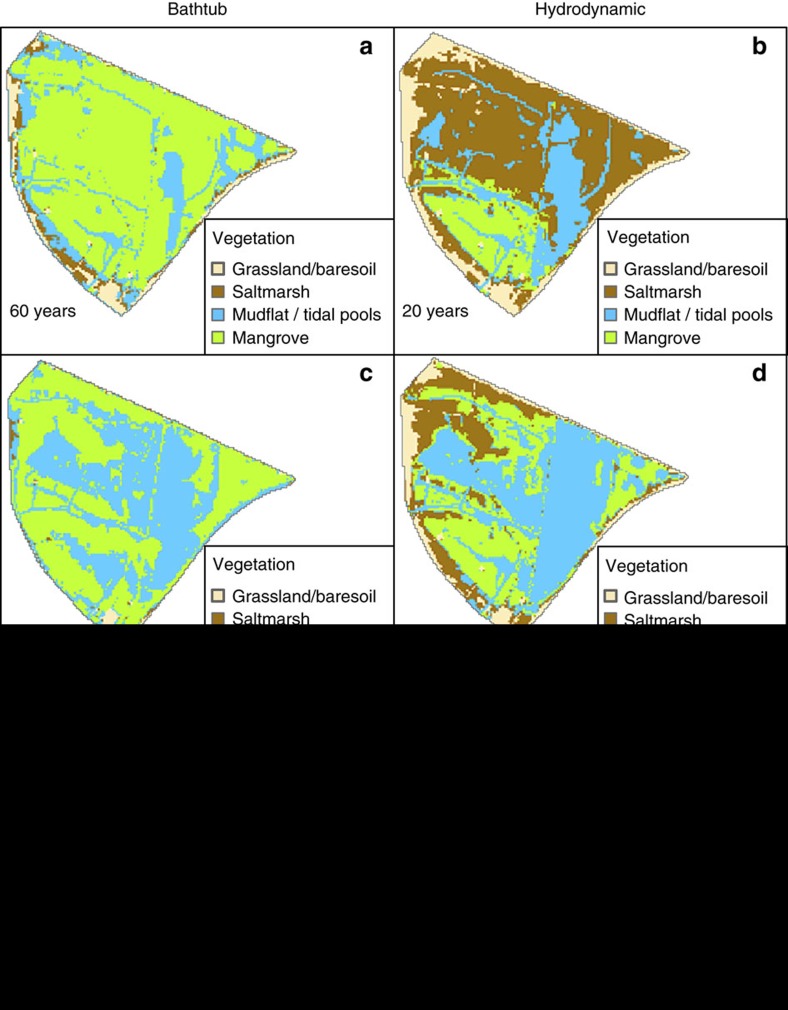
Wetland vegetation changes due to constant sea-level rise and constant soil surface elevation change.(a,b) 30–40% of vegetated area loss is predicted after 60 years in the bathtub model but considerably sooner (20 years) in the attenuated case. During this initial phase losses are partially compensated by colonization of higher buffer zones. (c,d) 50–55% of vegetation loss occurs after 80 and 40 years according to the bathtub and hydrodynamic model, respectively. Faster losses in this phase are associated with the disappearance of buffer zones. (e,f) 80–85% of vegetation loss at 120 years (bathtub model) and 80 years (hydrodynamic model) in this last phase indicates a slower rate of inundation related to the steeper relief of the higher areas of the wetland in the periphery. For complete results see Supplementary Figs 2 and 3.